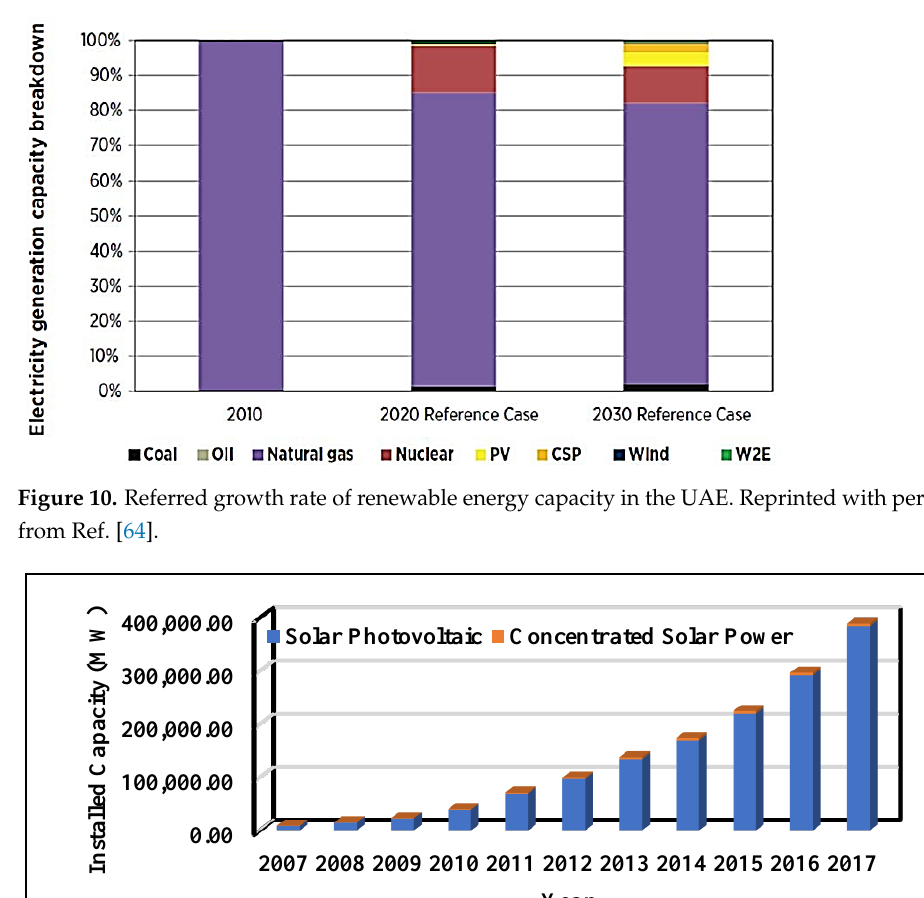
Figure 9. Fossil fuel energy consumption in the UAE [63].